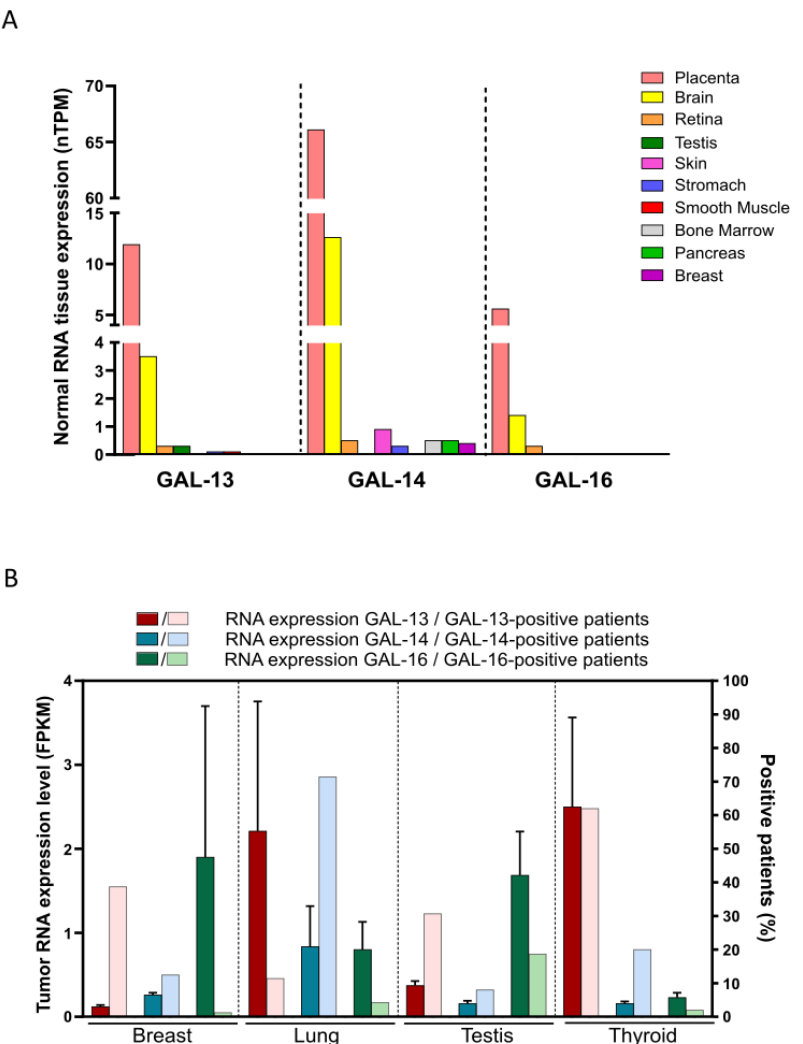
Figure 2. Comparison of placental galectins’ expression in normal and cancer tissues. ( A ) mRNA expression levels of placental galectins in normal tissues. Data were obtained from the Human Protein Atlas datasets. Normalized transcripts per million (nTPM) units are relative to normalized transcript expression values. ( B ) mRNA expression levels of placental galectins in cancer tissues. Data were obtained from the Human Protein Atlas datasets. FPKM units refer to fragments per kilobase of transcript per million mapped reads. The darker-colored histogram bars represent the mRNA expression levels of galectin, while the lightly colored histogram bars represent the percentage of patients with detectable expression levels.